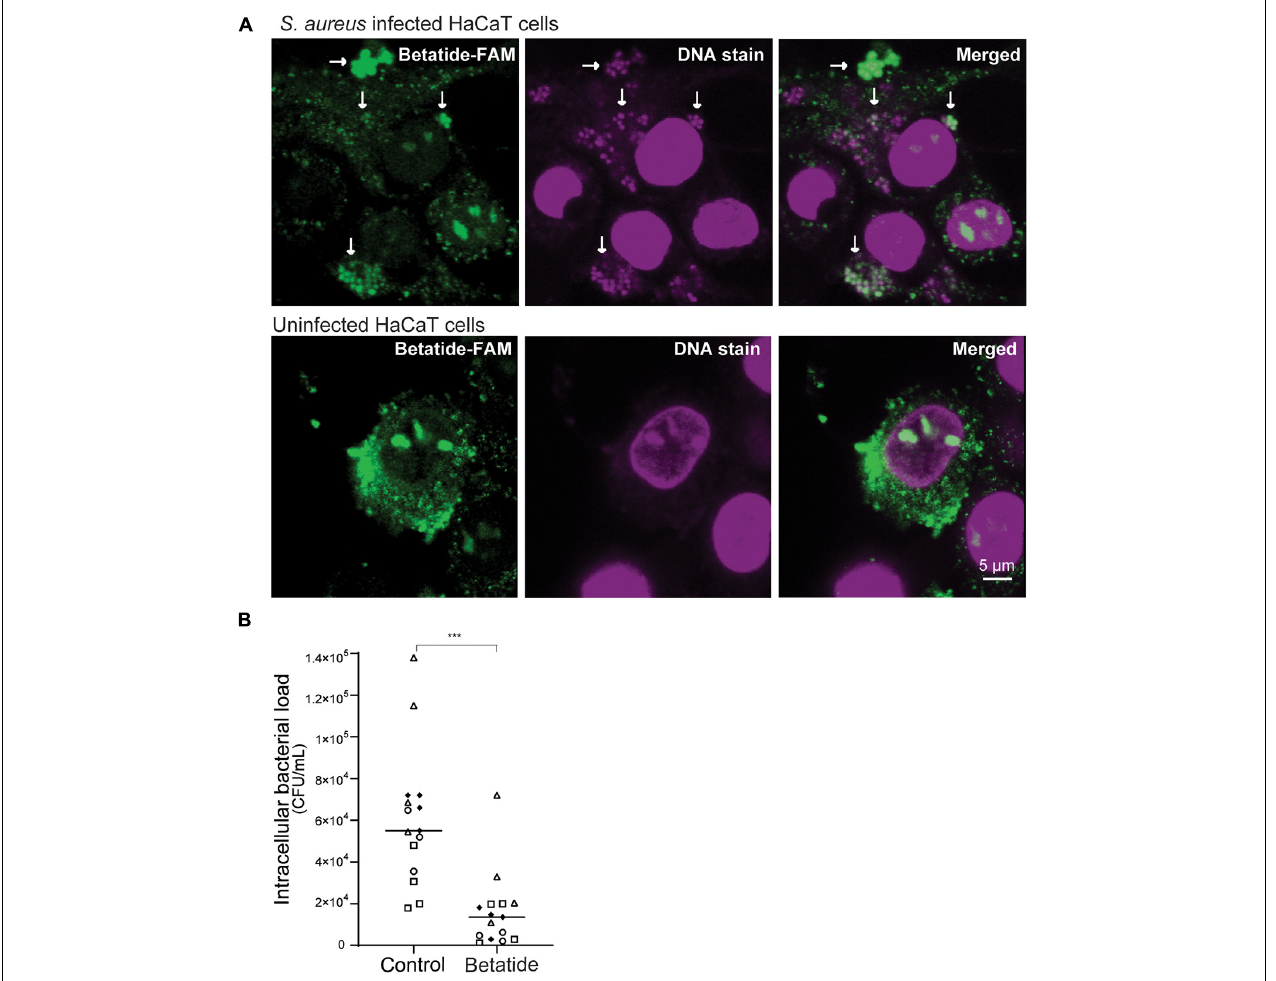
FIGURE 2 | Betatide reduces intracellular bacterial load in HaCaT cells infected with Staphylococcus aureus . (A) Images show import of fluorescently tagged betatide (betatide-FAM, 20 µ g/ml, green) in S. aureus ATCC 29213-infected HaCaT cells (upper panels) and uninfected HaCaT cells (lower panels). DNA is stained with Vybrant R (cid:13) DyeCycleTM Ruby stain (VDR, 5 µ M). Examples of small circular dots in the cytosol containing both betatide-FAM and DNA are marked with white arrows. (B) Intracellular bacterial load (CFU/ml) after S. aureus infection in HaCaT cells treated with betatide (24 µ g/ml for 16 h) compared to untreated control. Extracellular S. aureus were eradicated by gentamicin treatment prior to this exposure in both the control and betatide-treated samples. Technical replicates from each biological replicate are shown with identical symbols (circles, triangles, squares, and diamonds). *** p < 0.0001 in unpaired two-tailed t -test with Welch’s